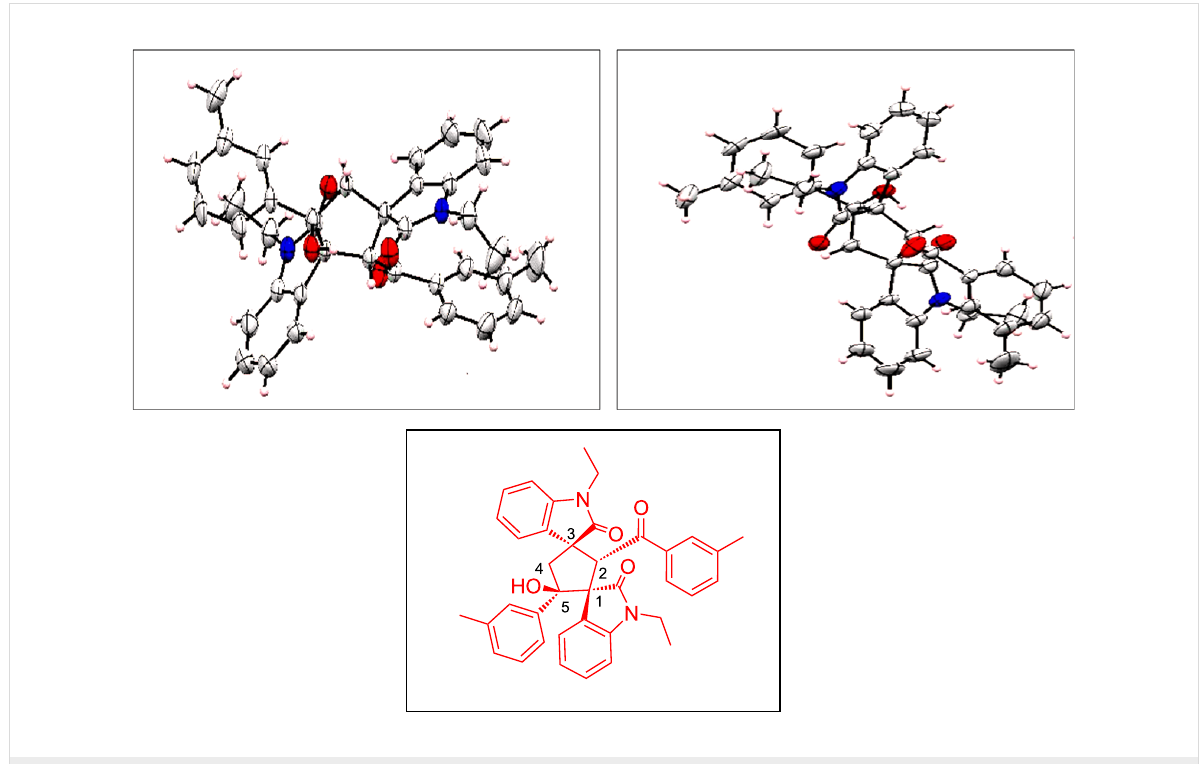
Figure 2: ORTEP diagram of product 3g (CCDC NO. 2072521).